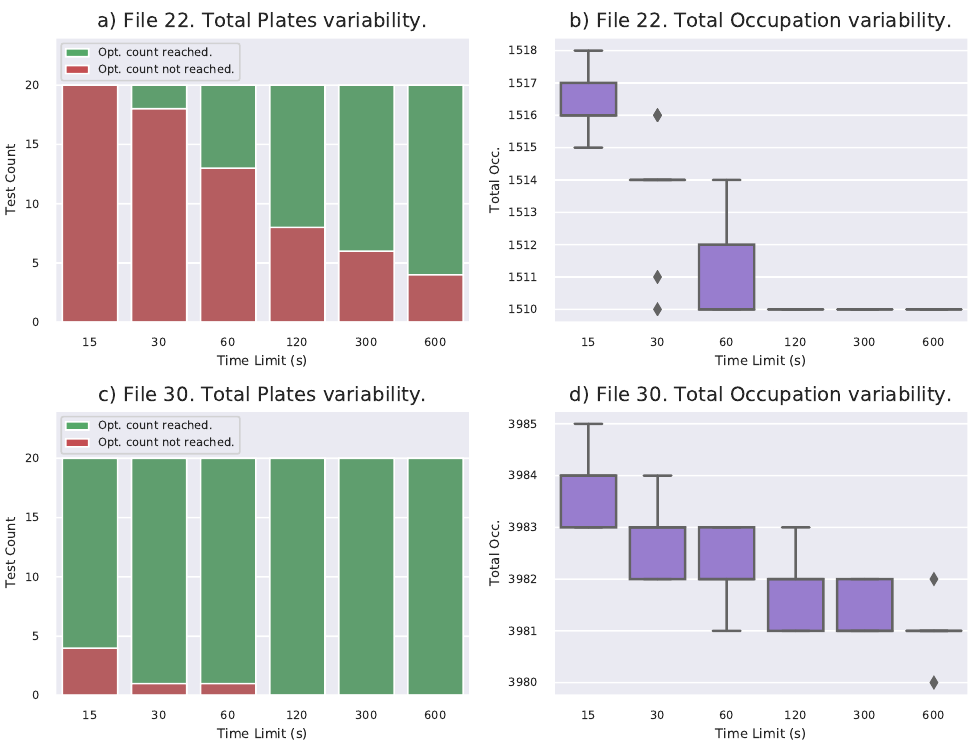
Figure 12. Evolution of M2 solutions over time, files 22 and 30.